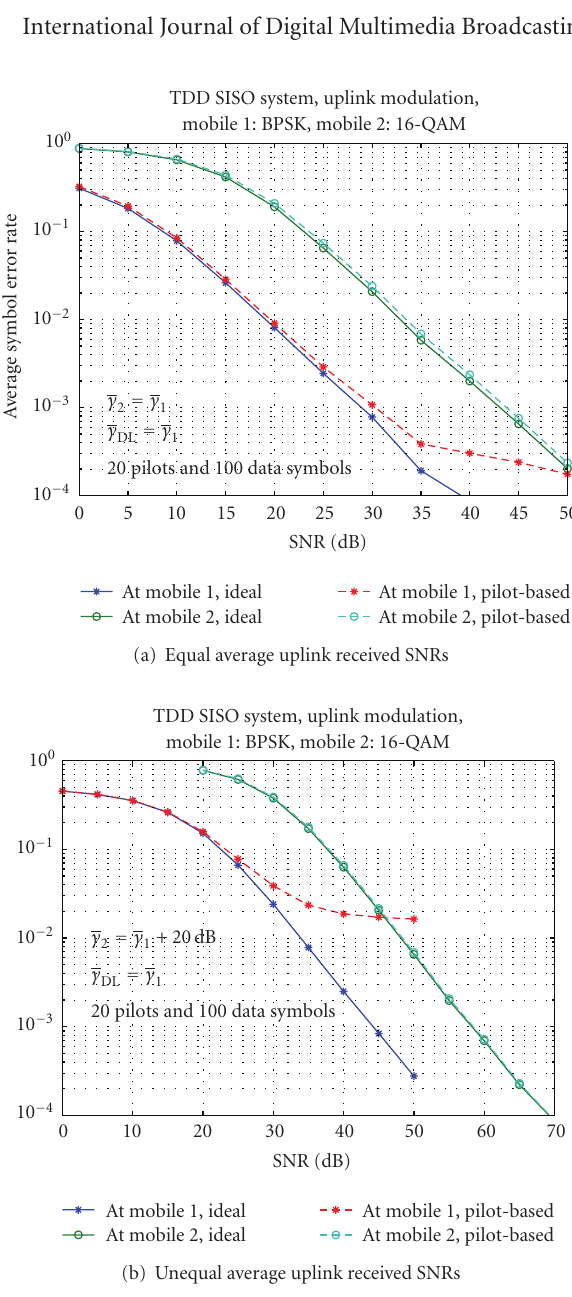
Figure 6: Average uncoded SER of MMSE-BAF system with QPSK modulation for user 1 and 16-QAM modulation for user 2.